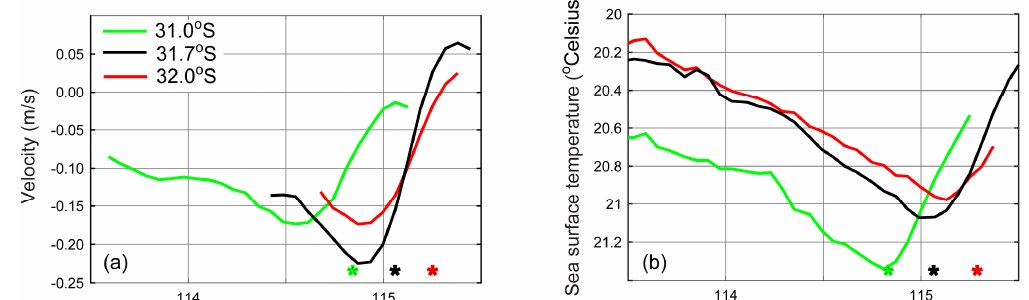
Figure 3. Mean cross-shelf profiles of ( a ) velocity; and, ( b ) sea surface temperature at different latitudes. The asterisk denotes the location of the 200 m depth contour. Units for the x -axis are °E.